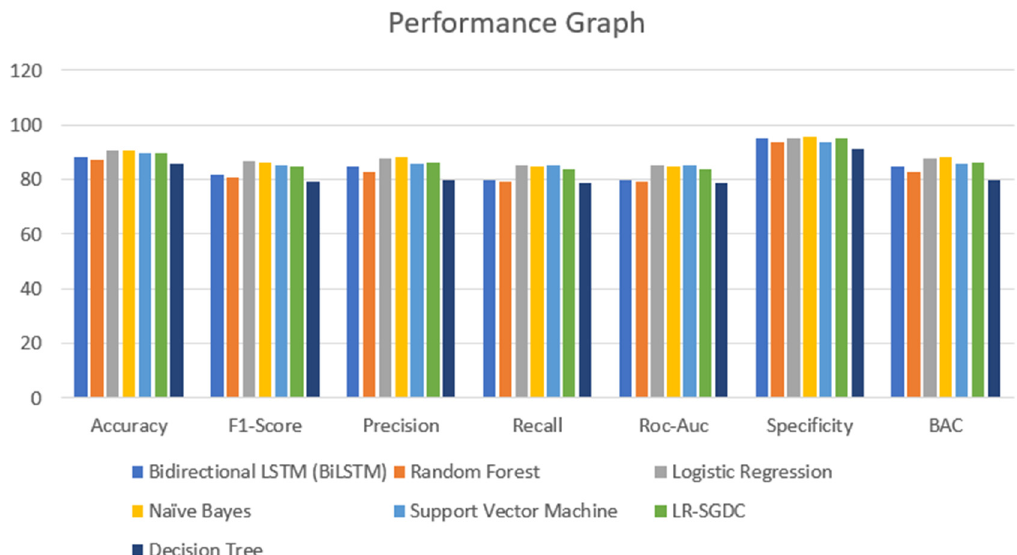
Figure 14 . Performance graph of different classifiers for the second dataset. Figure 14. Performance graph of different classifiers for the second